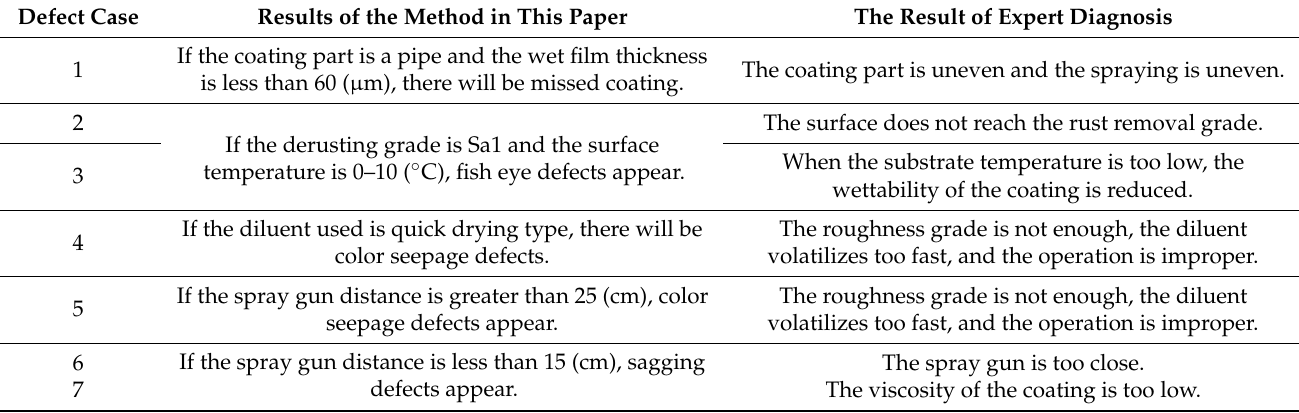
Table 12. The defect results of this method were compared with the expert diagnosis